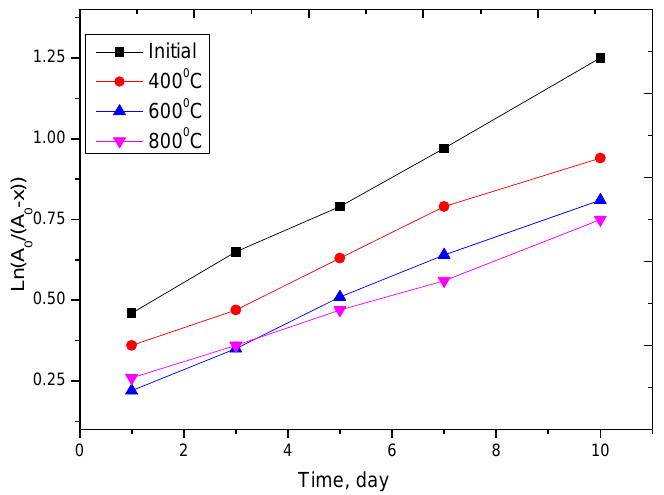
Figure 8. Anamorphosis of the kinetic curve for the oxidation reaction and degradation of investigated